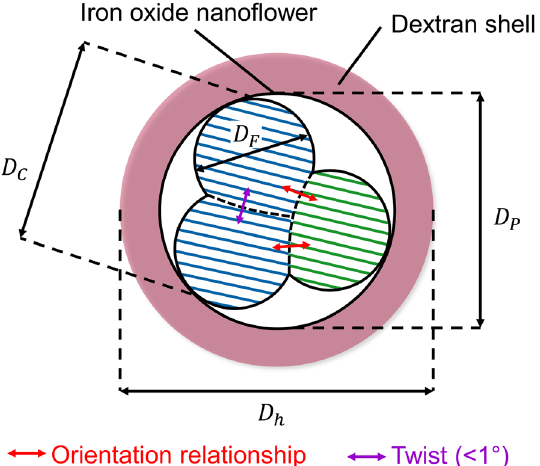
Figure 9. Schematic illustration of the hierarchical structure of a dextran-coated IONF, adapted from Gavilán et al. 35 and modified. Hydrodynamic diameter D h , particle diameter D P , core diameter D C and diameter of the core fragments D F are indicated. Red and purple arrows mark neighboring cores with lattice planes with matching interplanar spacings and fragmented cores with nearly identical crystallographic orientation,